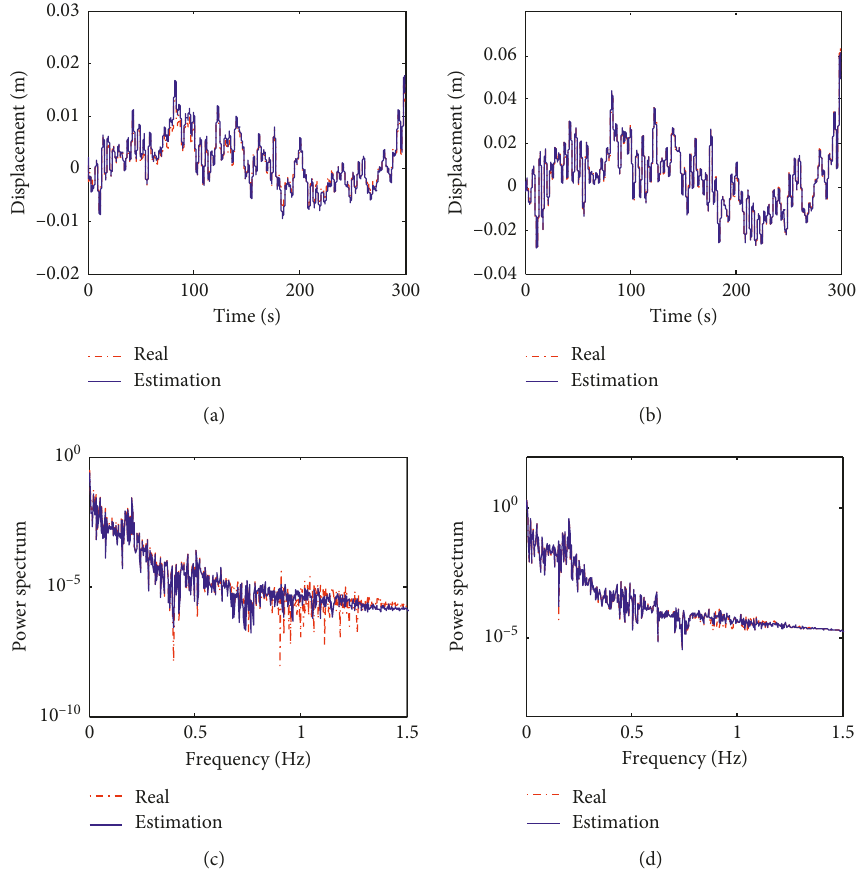
Figure 15: Comparison of the structural displacement responses in direction X under wind direction of 180 ° . Time history on the (a) 24th floor and (b) 58th floor. Power spectrum on the (c) 24th floor and (d) 58th